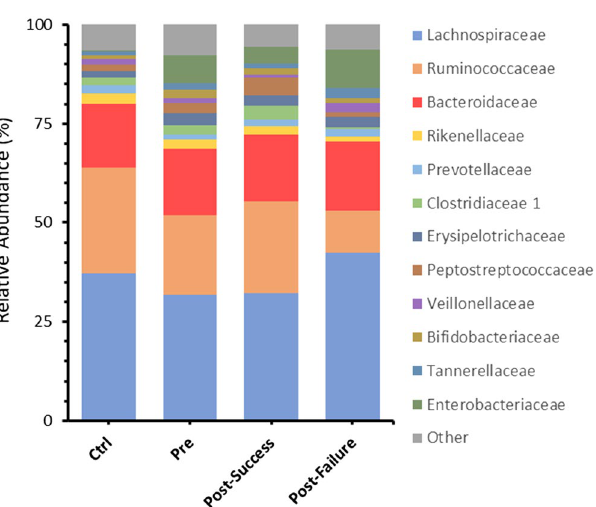
Figure 3. Bar charts showing mean values of ASV abundances at the family level in the four different groups studied: healthy individuals (control), Crohn’s disease patients pre-treatment (t0) and patients post-treatment (t1; in turn, classified into responders and non-responders). “Other” refers to all families with an initial representation less than 2% of